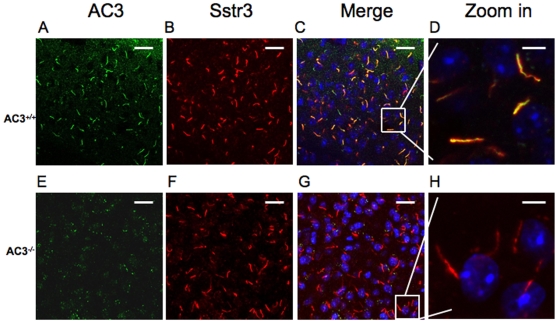
AC3 is expressed in the cilia of VMH neurons.(A,B,C,D) Representative images of AC3 immunoreactive cilia in the VMH regions of the hypothalamus in AC3+/+ mice labeled with antibodies AC3 (green) (A), Sstr3 (red) (B) and colocalization of AC3 and Sstr3 (merge). Scale bar, 20 µm. (E,F,G,H) Representative images of immunoreactive cilia in the VMH regions of the hypothalamus in AC3−/− mice labeled with antibodies AC3 (green) (E), Sstr3 (red) (F) and colocalization of AC3 and Sstr3 (merge). Scale bar, 20 µm. (D,H) Enlarged images of selected areas in of AC3+/+ (D) and AC3−/− (H). Scale bar, 5 µm. Nuclei are stained with Hoestch (blue). N = 3 for each genotype.